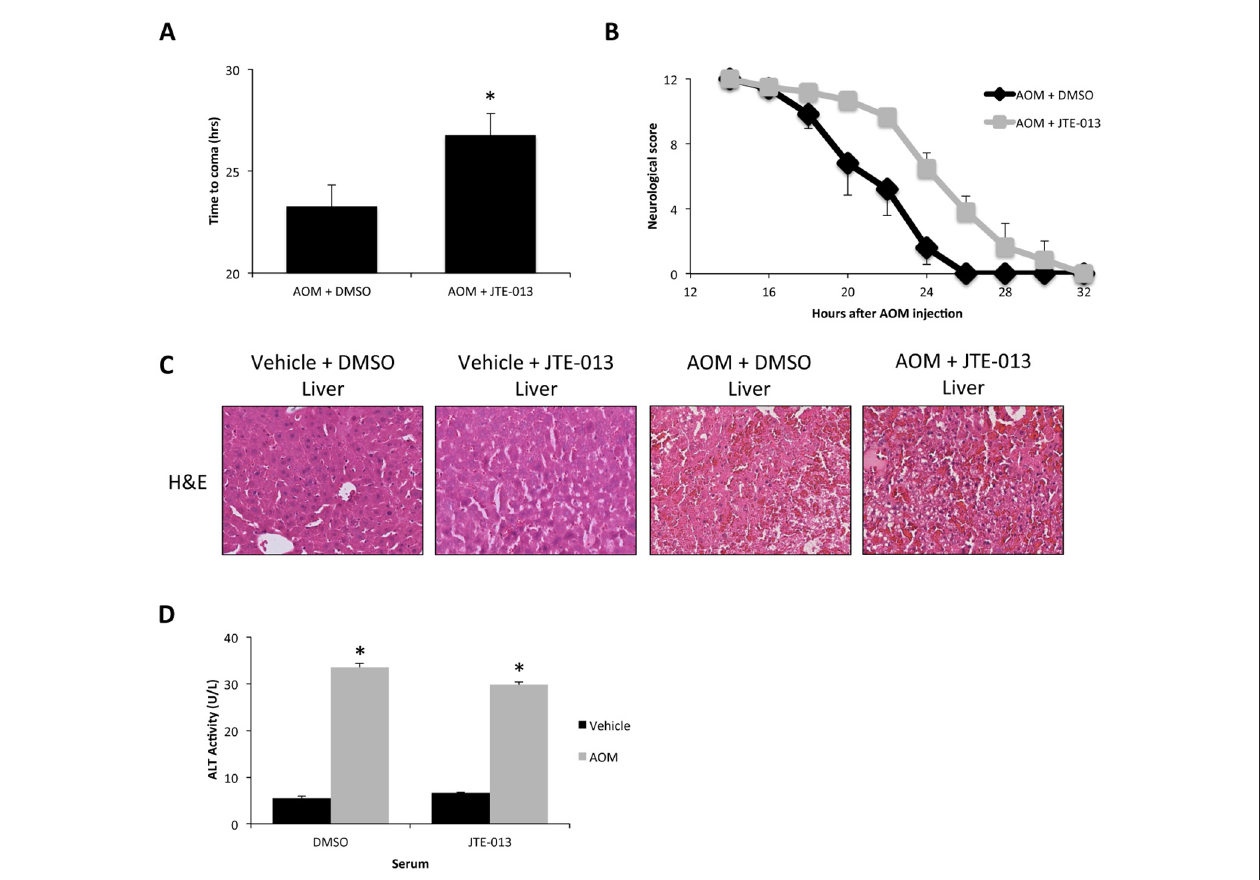
FIGURE 5 | JTE-013 infusion reduces neurological decline without influencing hepatic injury in AOM-treated mice. (A) Time taken to progress to coma in hours of AOM-treated mice infused with DMSO or JTE-013. (B) Neurological score analyses as assessed by reflex scores and ataxia at the indicated hours post AOM injection in AOM-treated mice infused with DMSO or JTE-013. (C) Representative H&E images from the livers of vehicle or AOM-treated mice infused with DMSO or JTE-013. (D) Alanine aminotransferase (ALT) activity in the serum of vehicle or AOM-treated mice infused with DMSO or JTE-013. ∗ p < 0.05 compared to AOM + DMSO (for time to coma analyses) or vehicle-treated mice infused with DMSO (for serum ALT activity analyses). n = 6 for time to coma and neurological score analyses and n = 4 for serum ALT